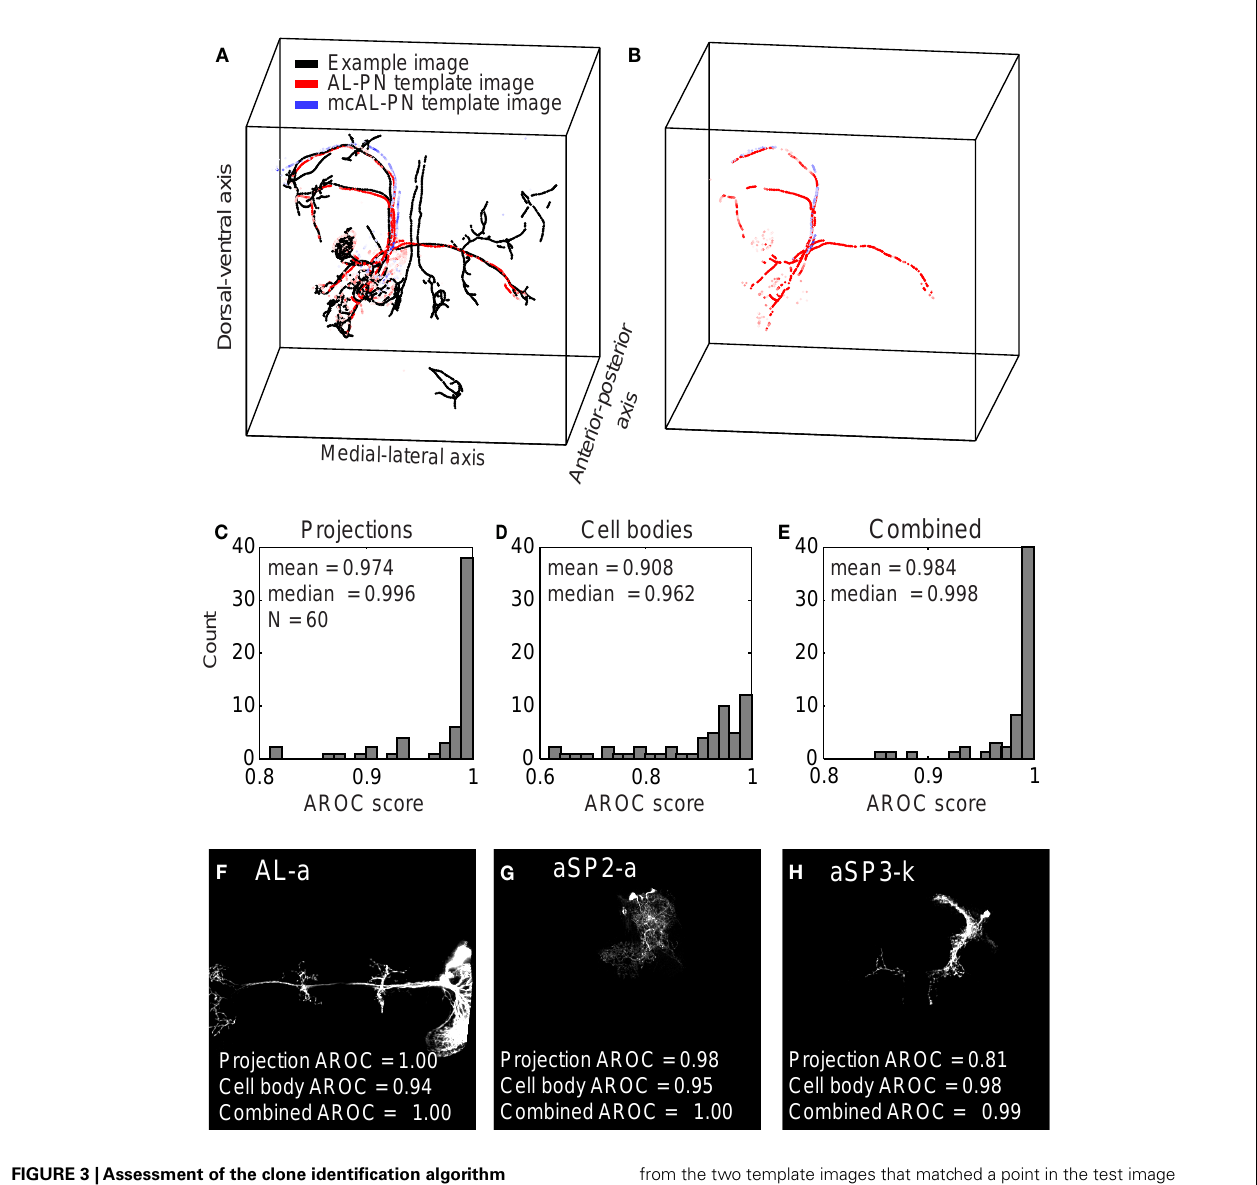
FIGURE 3 |Assessment of the clone identification algorithm using cross-validation. (A) A processed test image (black points) containing an AL-PN clone is compared against a AL-PN template image (red points) and a mcAL-PN template image (blue points).The brightness of the red and blue points correspond to the mutual information of the point. (B) Same as (A) , except only those points